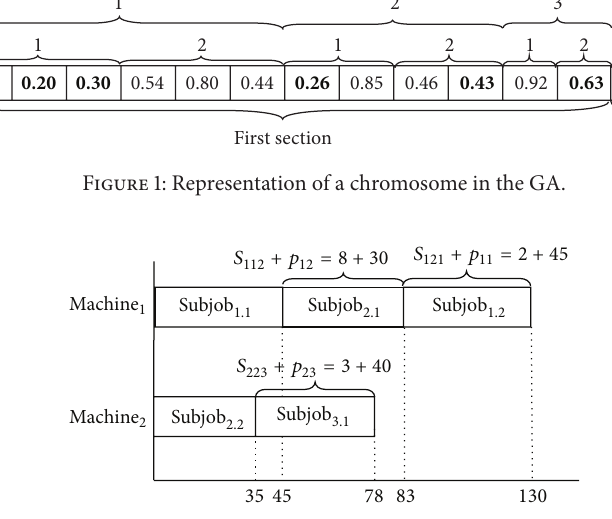
Figure 2: Resulting schedule and 𝐶 max for chromosome in Figure